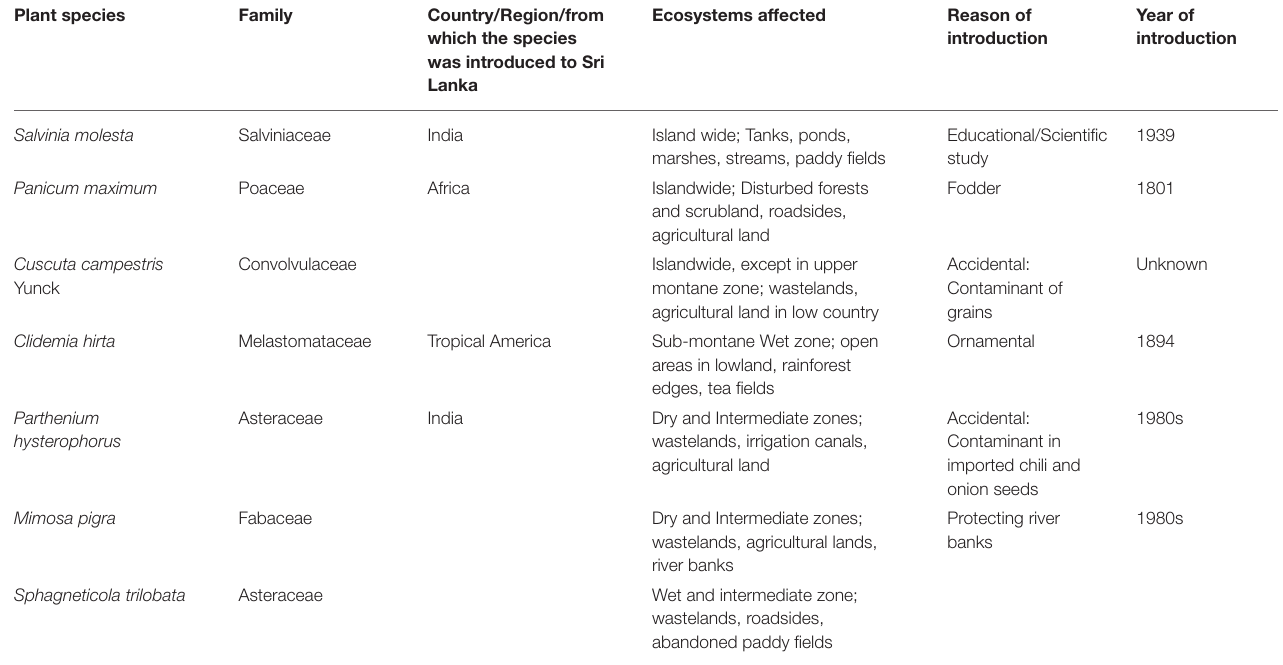
TABLE 4 | Invasive alien flora in agro-ecosystems of Sri Lanka (source: updated from Wijesundara, 2010). Plant